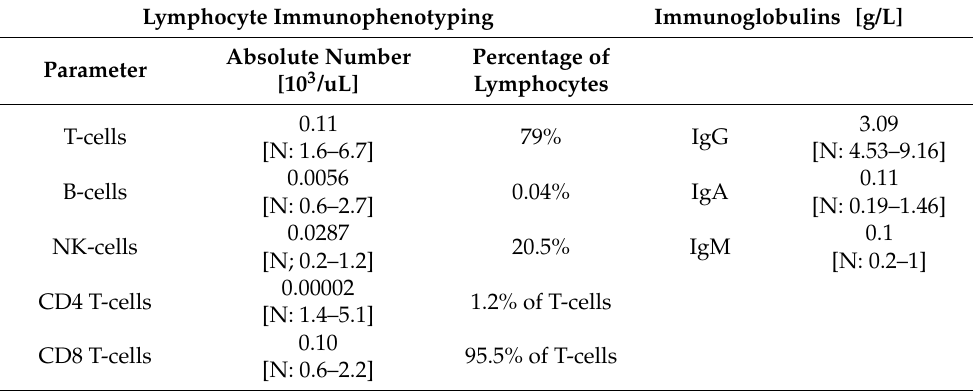
Table 3. Immunological